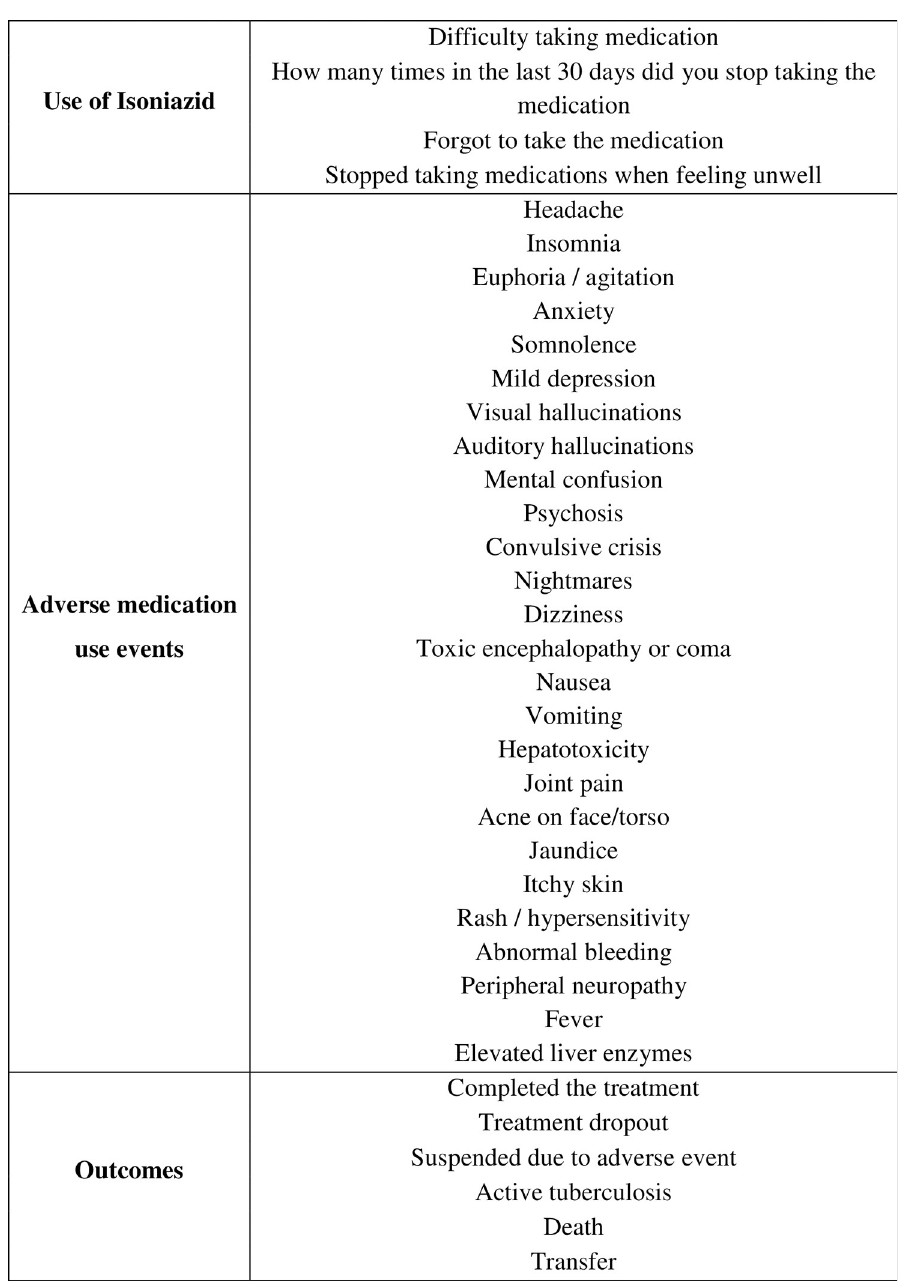
Fig 3. Variables of interest in the follow-up of the pragmatic randomized clinical trial designed to evaluate the completion of treatment of latent Mycobacterium tuberculosis infection with isoniazid in 300 mg formulation, Brazil, from 2019 to